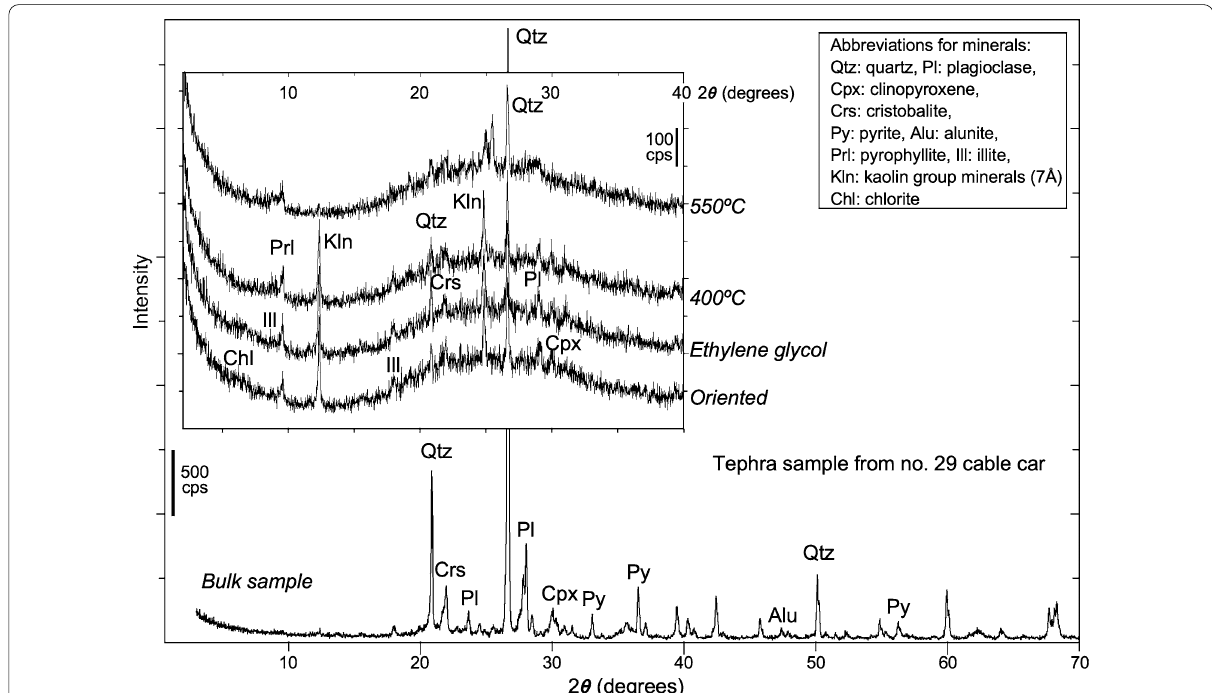
Fig. 7 XRD spectrum of tephra sample (KSs-04) from no. 29 cable car, showing bulk sample and clay matrix data (inset)